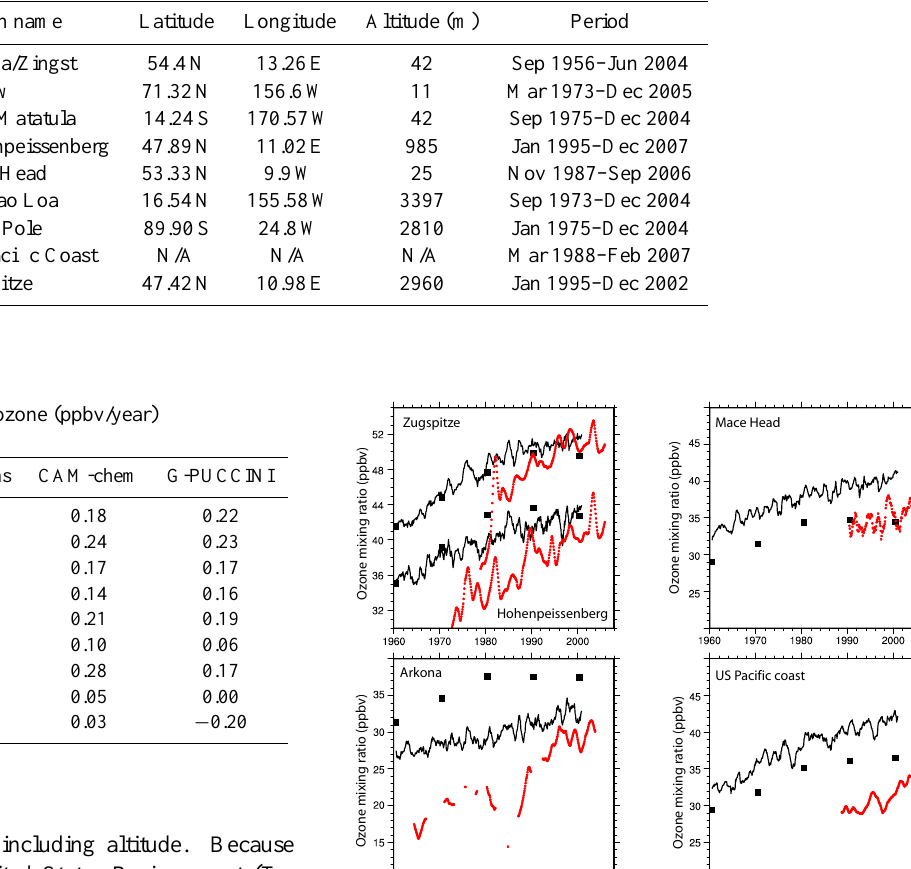
Table 10. List of stations.